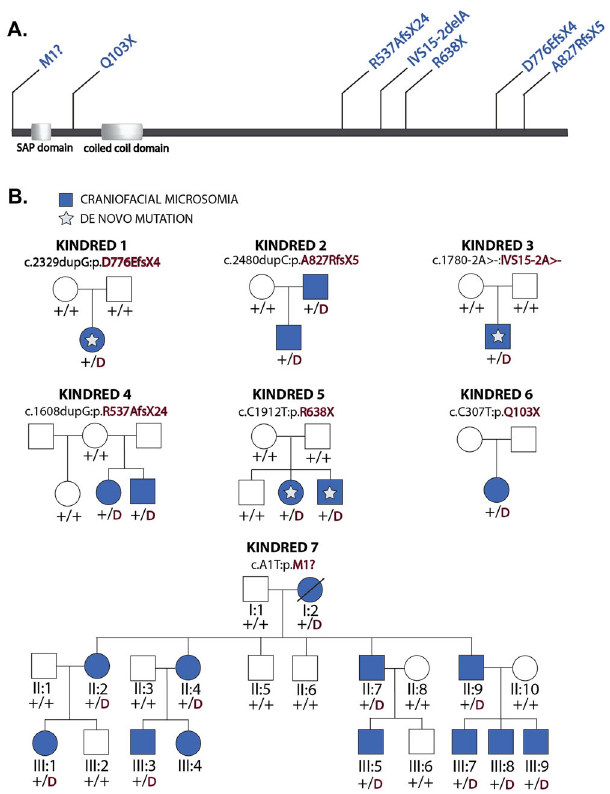
Fig. 1 SF3B2 variants in pedigrees with craniofacial microsomia. A` Domain structure of SF3B2 with variants identi fi ed noted above.